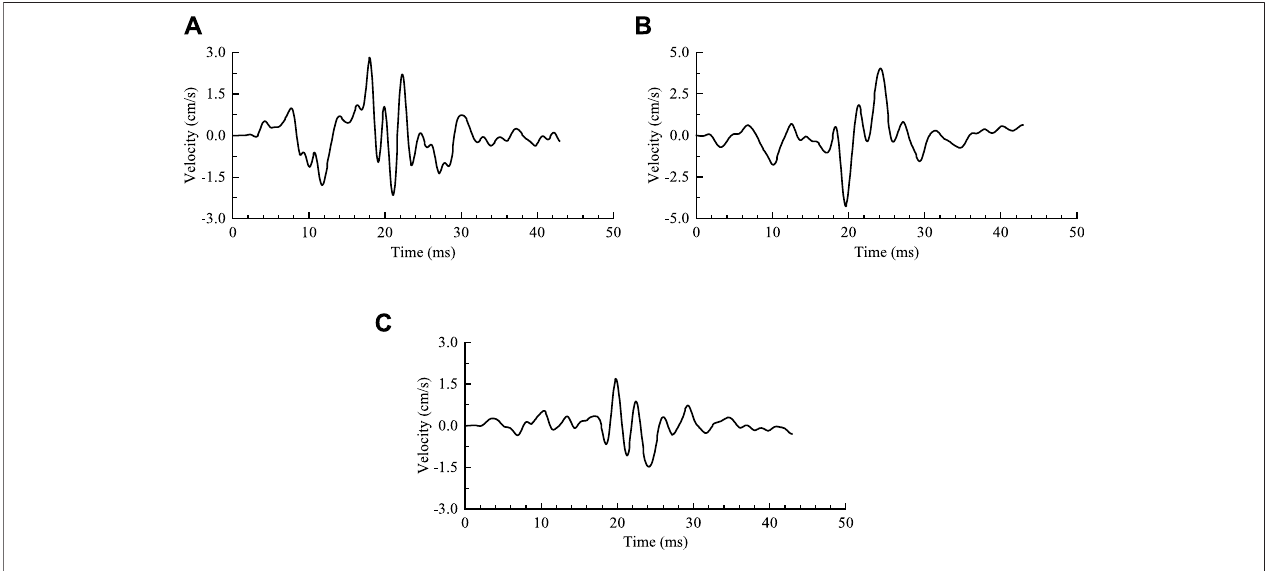
FIGURE 8 | Velocity histories monitored on site during the cut hole blasting. (A) Transverse component, (B) Vertical component, (C) Longitudinal component.